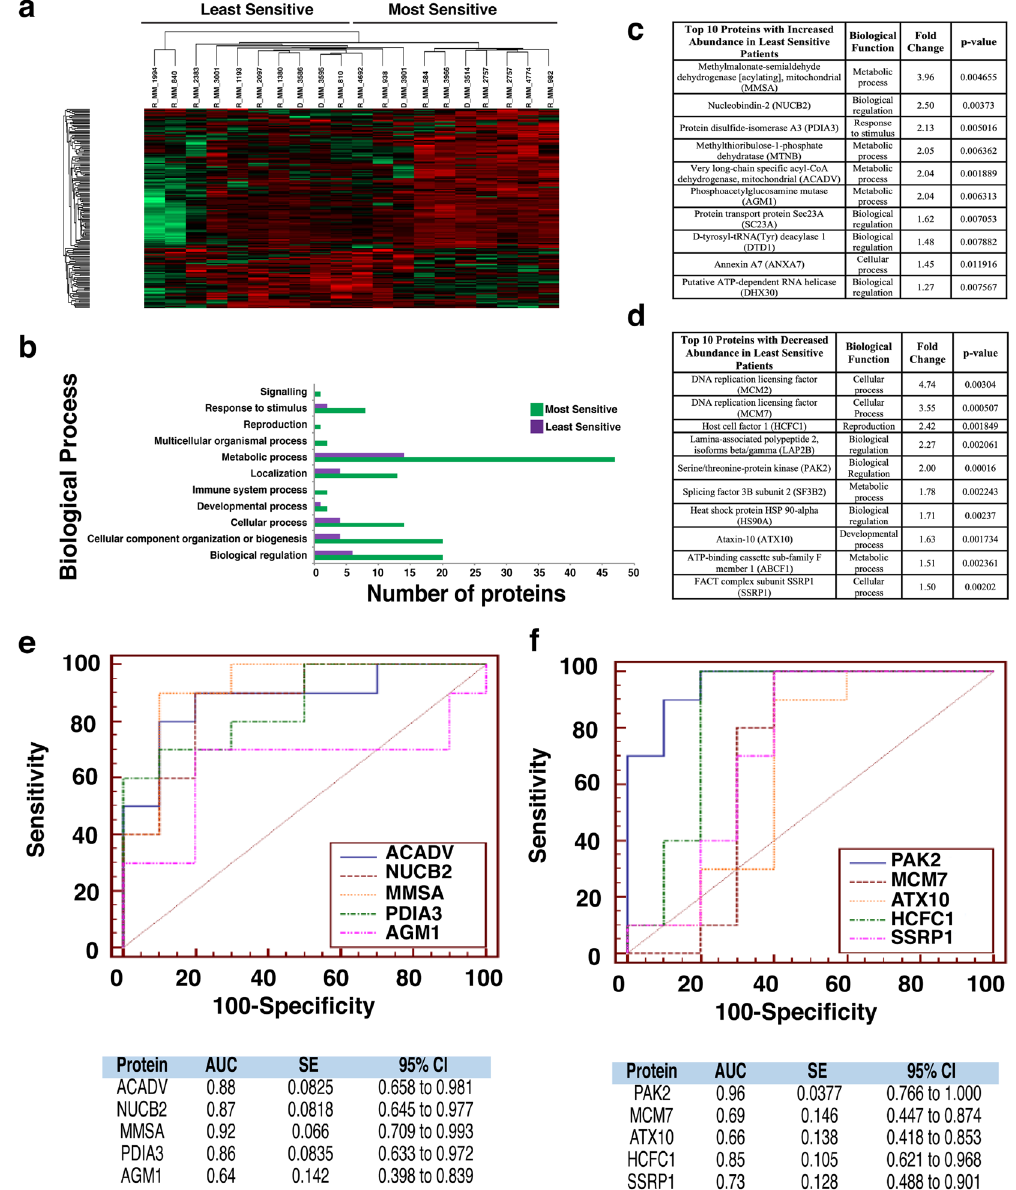
Figure 5. Proteomic analysis of patients following Lenalidomide treatment. ( a ) Heatmap showing protein abundance changes of patients most and least sensitive to lenalidomide. Red indicates an increase in protein abundance, while green a decrease in protein abundance. ( b ) Graph showing the biological processes associated with the most and least sensitive patients. ( c ) List of the top ten proteins with increased abundance in the least sensitive patients. The associated biological function, fold change and p-value are also shown. Proteins were designated by p-value and arranged hierarchically by fold change. ( d ) List of the top ten proteins with decreased abundance in the least sensitive patients. The associated biological function, fold change and p-value are also shown. Proteins were designated by p-value and arranged hierarchically by fold change. ( e ) ROC analysis for the top five statistically significant proteins with an increased abundance for the least sensitive patients to Lenalidomide, including the calculated AUC, standard error (SE) and 95% confidence interval (CI). ( f ) ROC analysis for the top five statistically significant proteins with a decreased abundance for the least sensitive patients to Lenalidomide, including the calculated AUC, standard error (SE) and 95% confidence interval